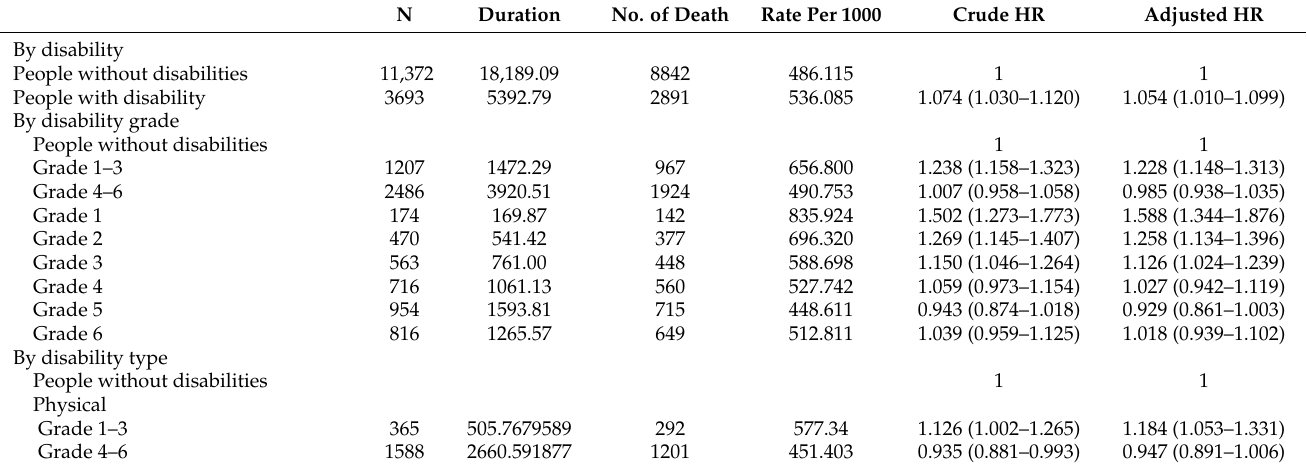
Table 5. Cancer-specific mortality in patient with bile duct